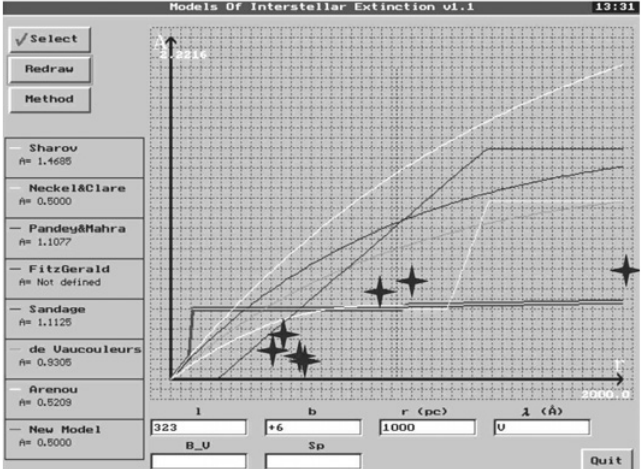
Fig. 1. Results for the test objects (stars) together with a number of previously published 3D